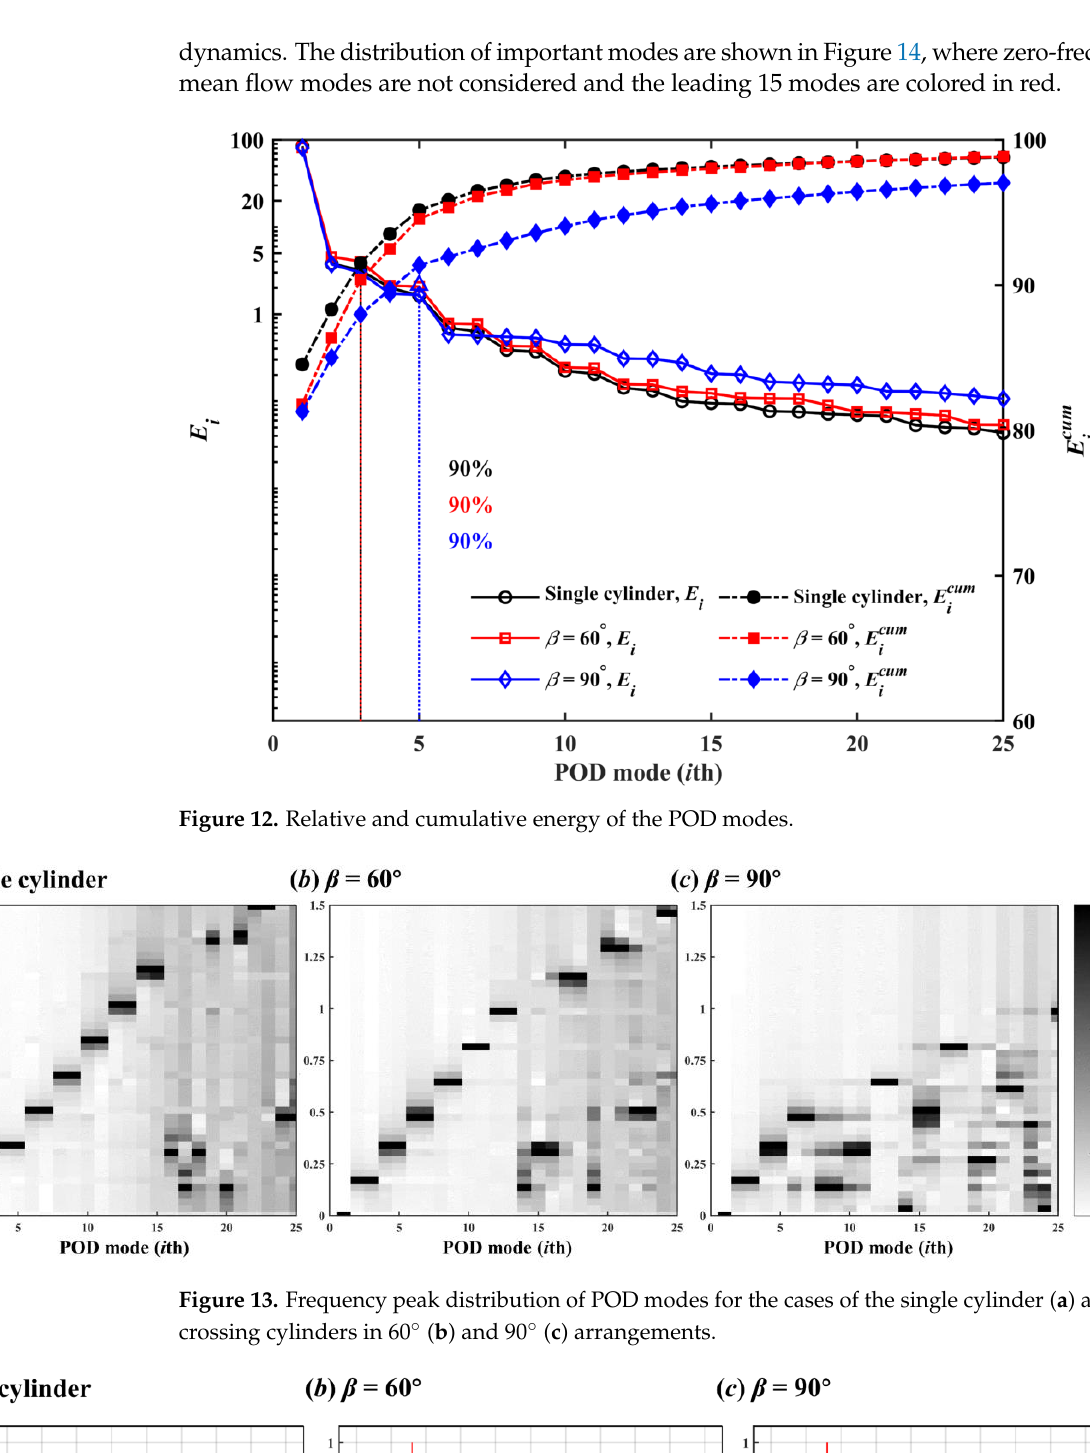
12 of 28 Figure 11. RMSE of the DMD reconstruction as a function of sampling interval with coverage pe- riod. 4.4. Modal Energy and Spectrum Statistics POD provides modal energy and time coefficient (see Equation (4)), and its spectral information can be obtained by calculating the time coefficient’s PSD. DMD provides modal eigenvalue λ i , frequency f i and amplitude α i (see Equations (9), (11), and (12)). Sta- tistics on these important parameters are given as follows.